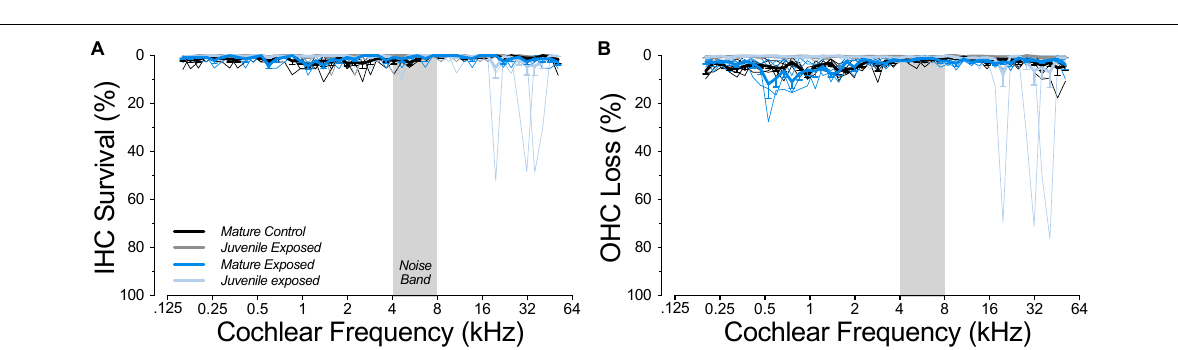
other cases the loss extends as far apical as the 4-kHz place,